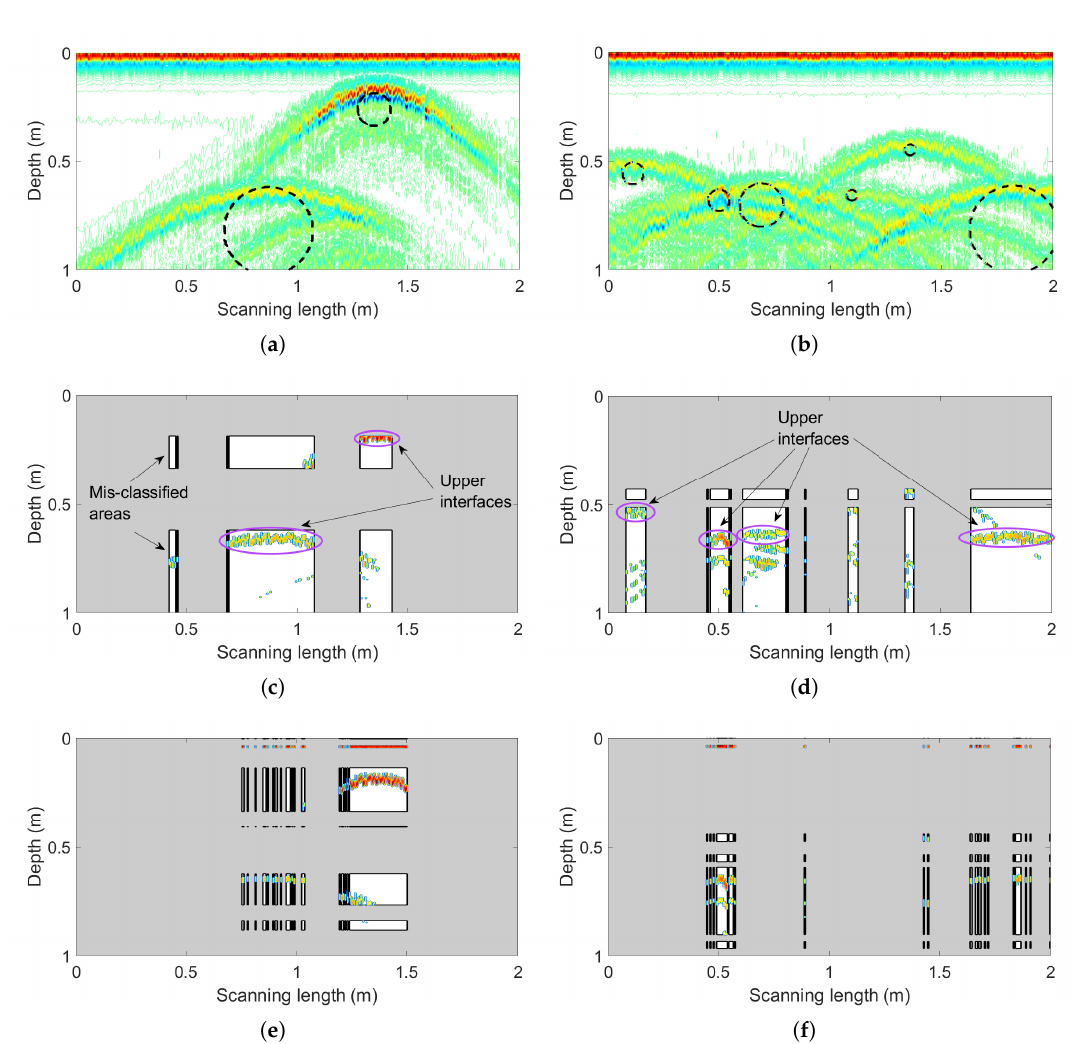
Figure 14. ( a ) The example profile with two pipelines (central coordinates and diameters ((1.355 m, 0.263 m), 0.15 m) & ((0.875 m, 0.823 m), 0.4 m)) considering surface roughness. ( b ) The example profile with six pipelines (left five central coordinates and diameters ((0.12 m, 0.56 m), 0.1 m) , ((0.505 m, 0.658 m), 0.1 m), ((0.695 m, 0.705 m), 0.2 m), ((1.1 m, 0.66 m), 0.05 m) & ((1.365 m, 0.453 m), 0.05 m), and rightest height and width (0.385 m, 0.37 m)) considering surface roughness. ( c ) The reconstructed profile of panel (a) by the proposed learning framework. ( d ) The reconstructed profile of panel (b) by the proposed learning framework. ( e ) The reconstructed profile of panel (a) after the independent SVM for comparison. ( f ) The reconstructed profile of panel (b) after the independent SVM for